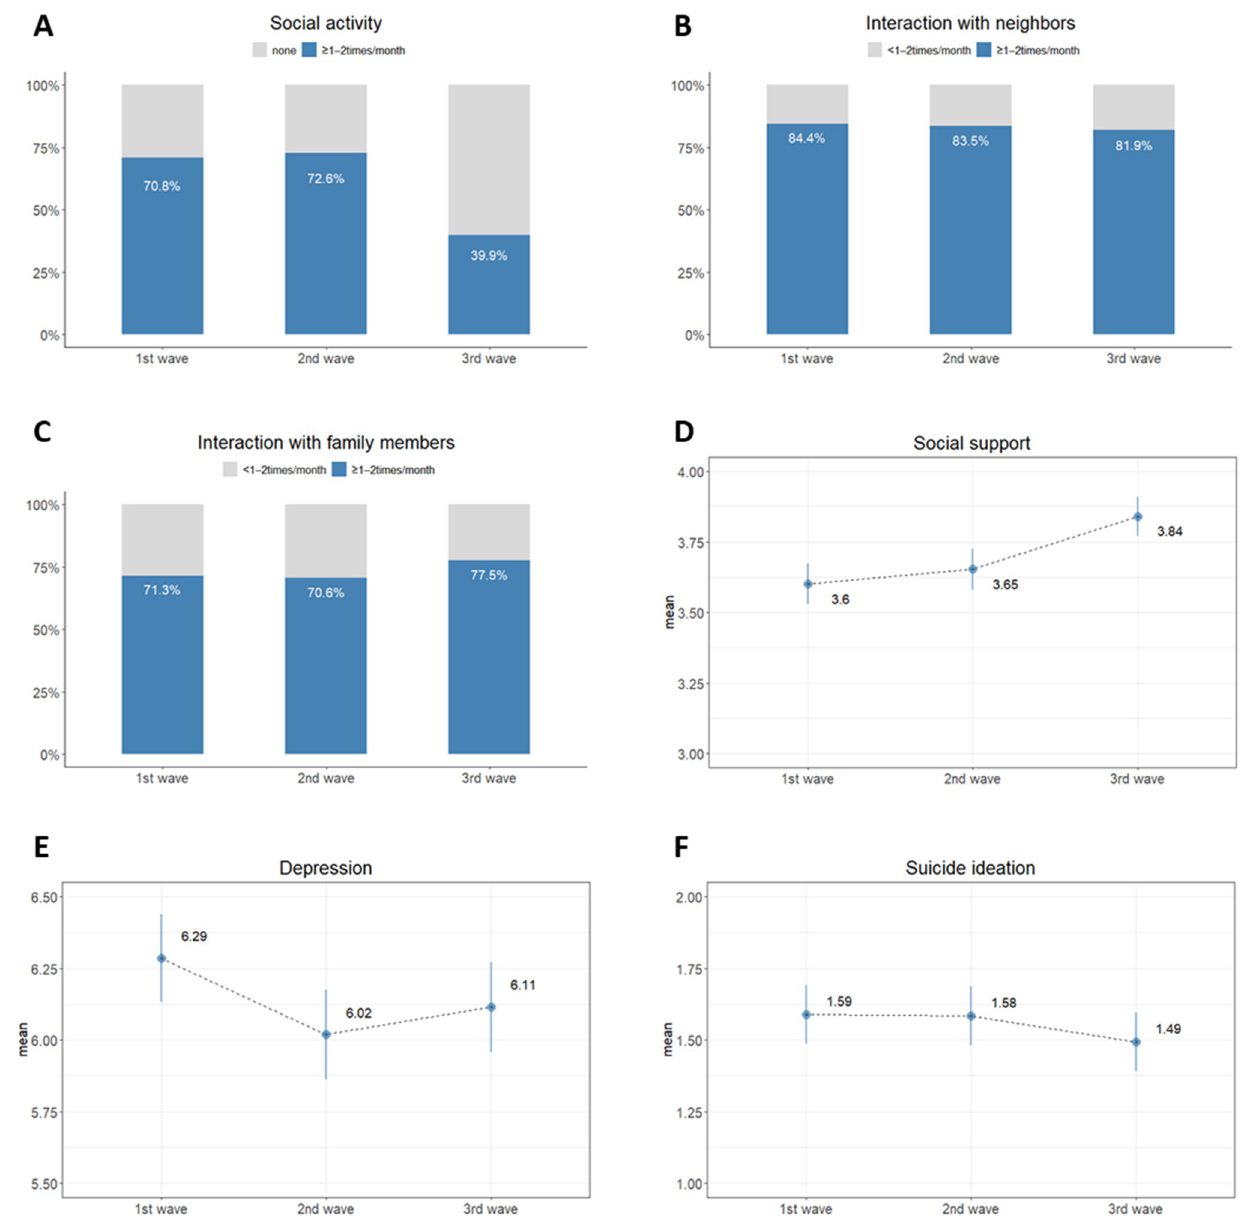
Fig 2. Social relationship and mental health change across